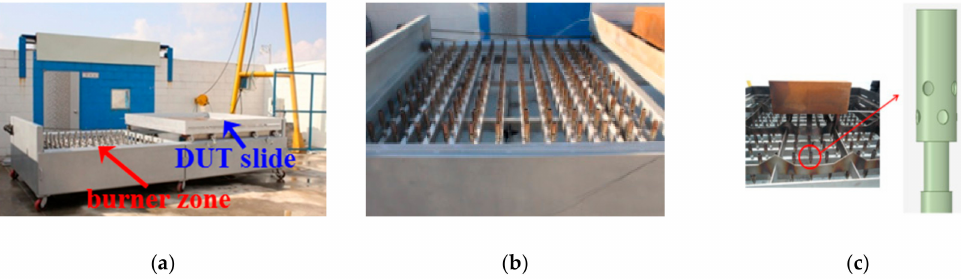
Figure 1. Configurations of prototype test apparatus: ( a ) front view of apparatus; ( b ) burner zone (156 EA); ( c ) Bunsen burner.